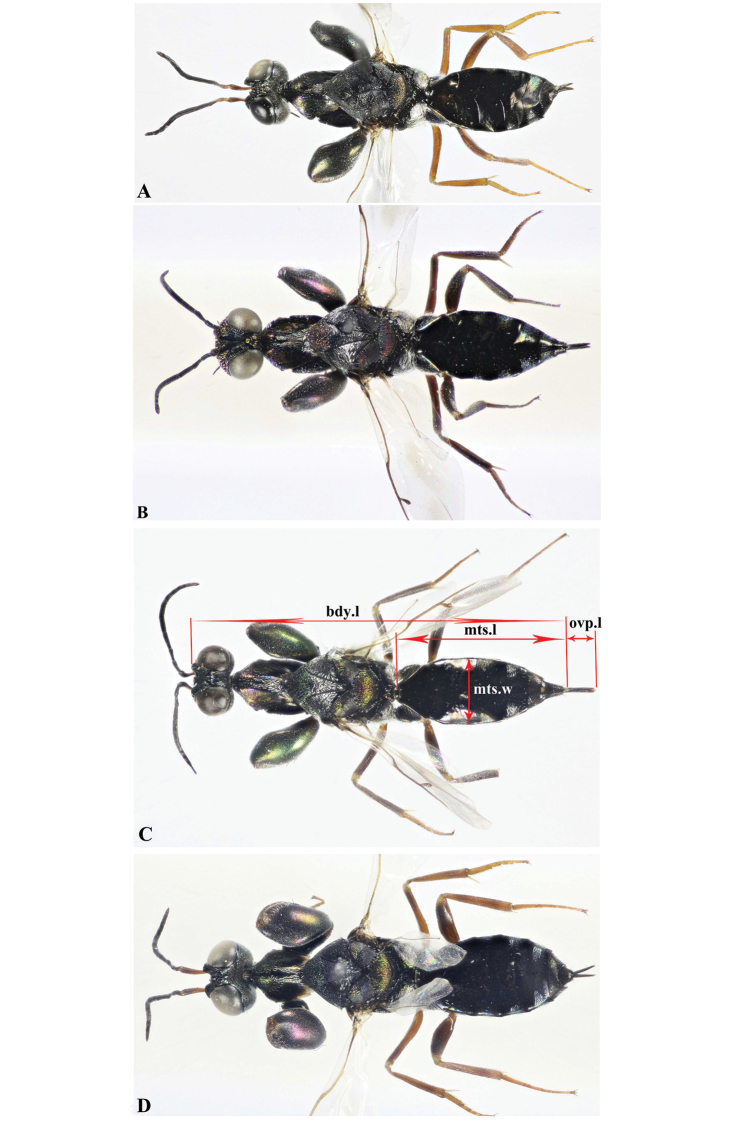
Dorsal habitus, Holotype AOodera
arabica sp. nov. BOodera
omanensis sp. nov. COodera
rapuzzii sp. nov. DOodera
similis sp. nov.